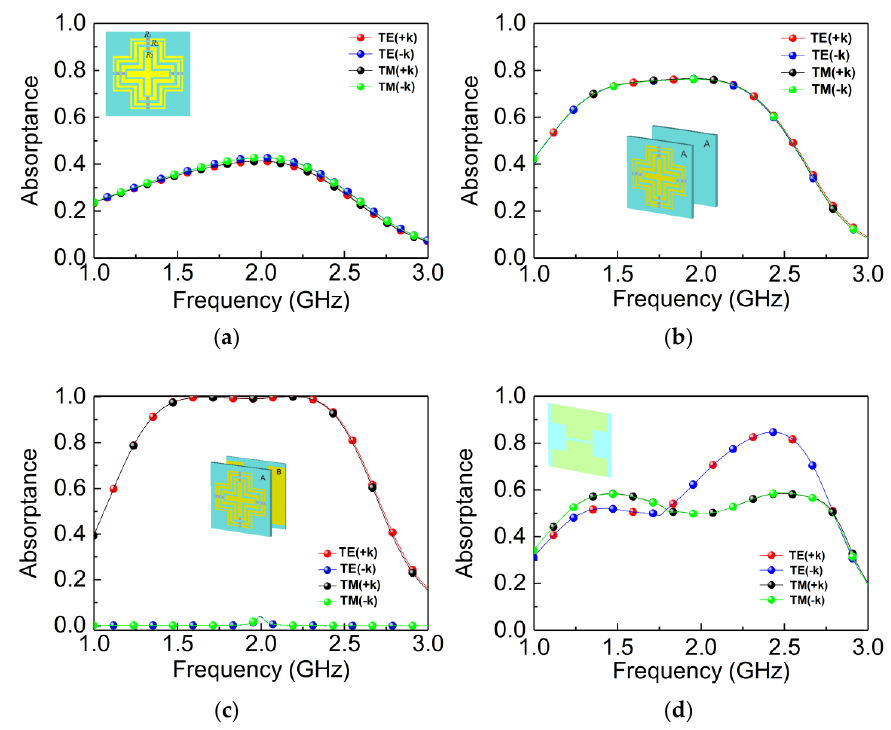
Figure 4. Absorptance under different combination structures. ( a ) Single A structure; ( b ) A-A structure; ( c ) A-B structure; ( d ) parallel-pasted I-shaped structures of the B layer. Herein, we also discuss the geometric influence of the directional insensitive MPA.